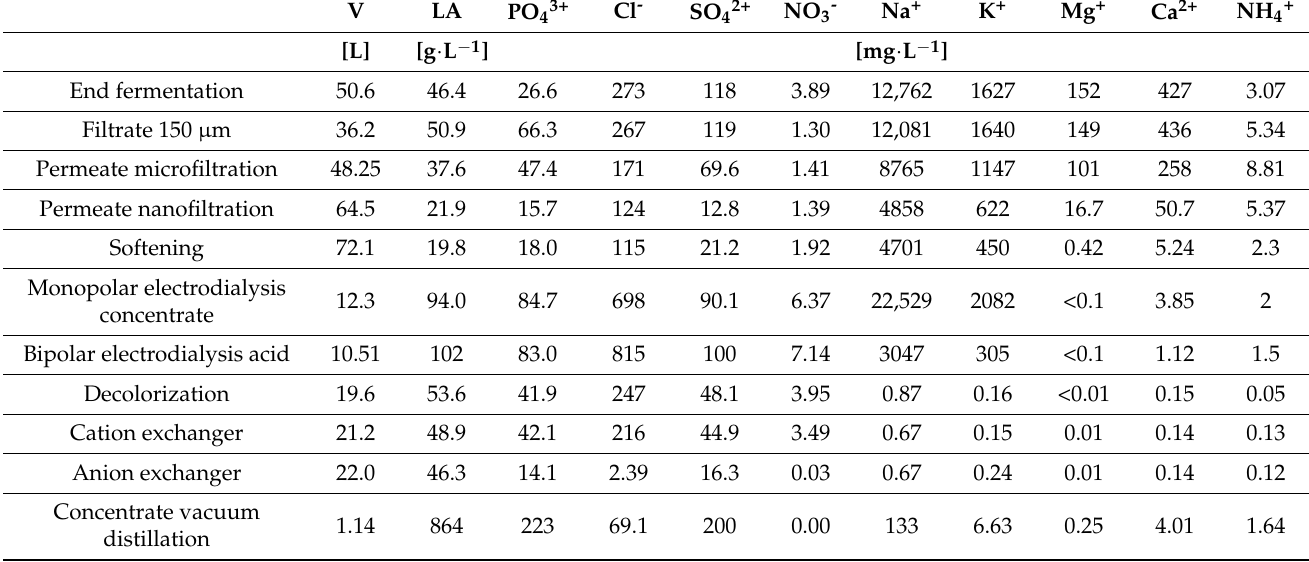
Table 1. Compositional analysis was detected after every step of the downstream process of the fermentation broth, obtained during the pilot scale fermentation process, using the carob bagasse as a